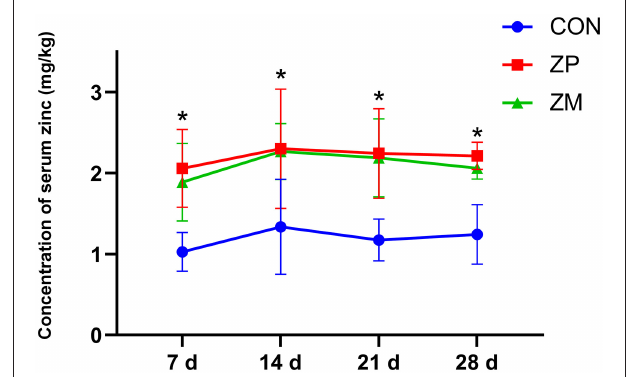
a , b Mean values in the same row with different superscripts are significantly different (P < 0.05). 1 Treatment:CON,noorganiczincsupplementation;ZPgroup,provided522.88mgzincproteinate(equivalentto80mgzinc/day);ZMgroup,provided467.88mgZMperday(equivalent to 80mg zinc/day).